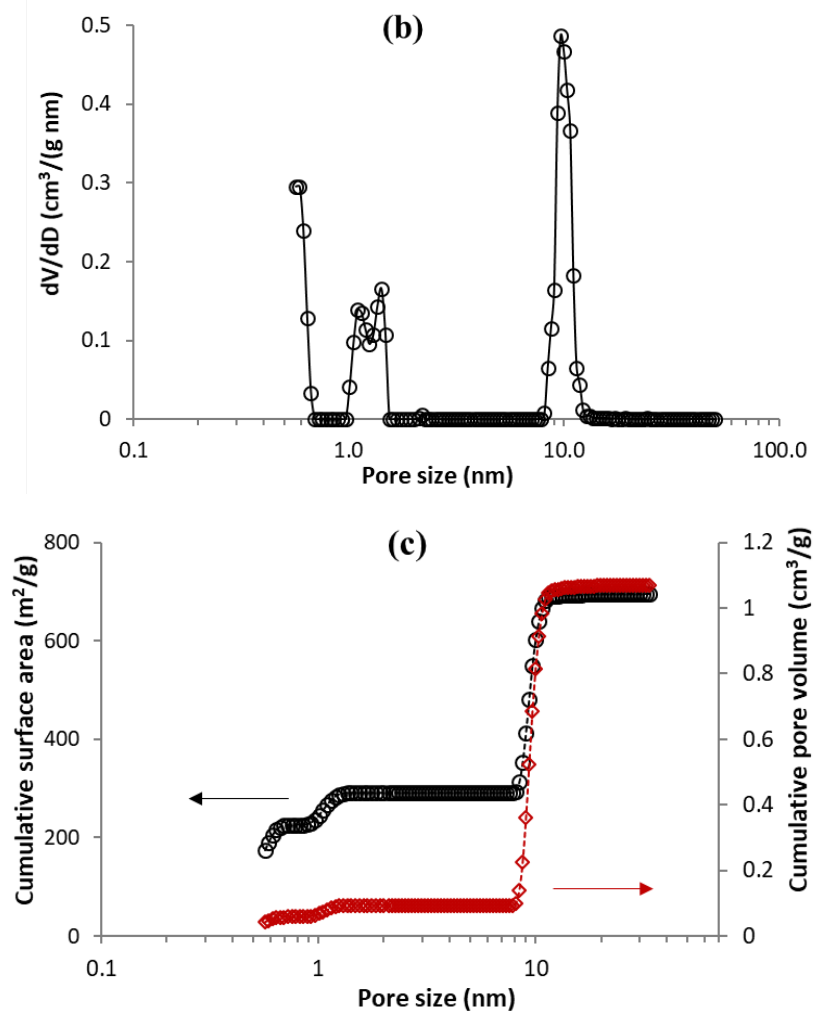
Figure 3. Nitrogen adsorption at −1 96 °C (solid circles) and desorption (empty circles) isotherms on MC sample ( a ), semi-logarithmic pore size distribution obtained by DFT method ( b ), and corresponding cumulated surface area (black) and pore volume (red) ( c ).